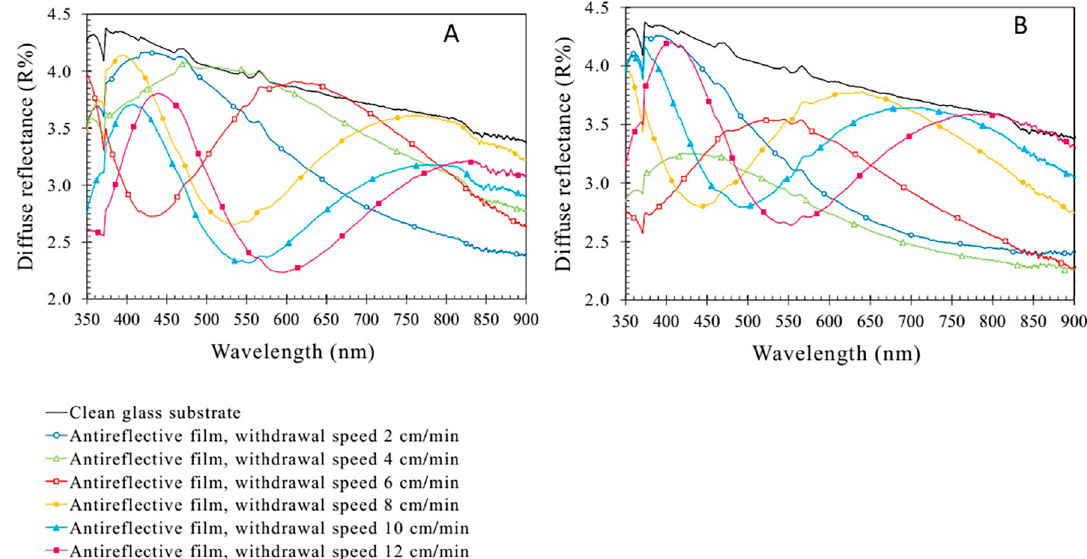
Figure 2. Diffuse reflectance spectrum of the glass substrate and the antireflective films without heat treatment (A) and antireflective films with heat treatment (B)